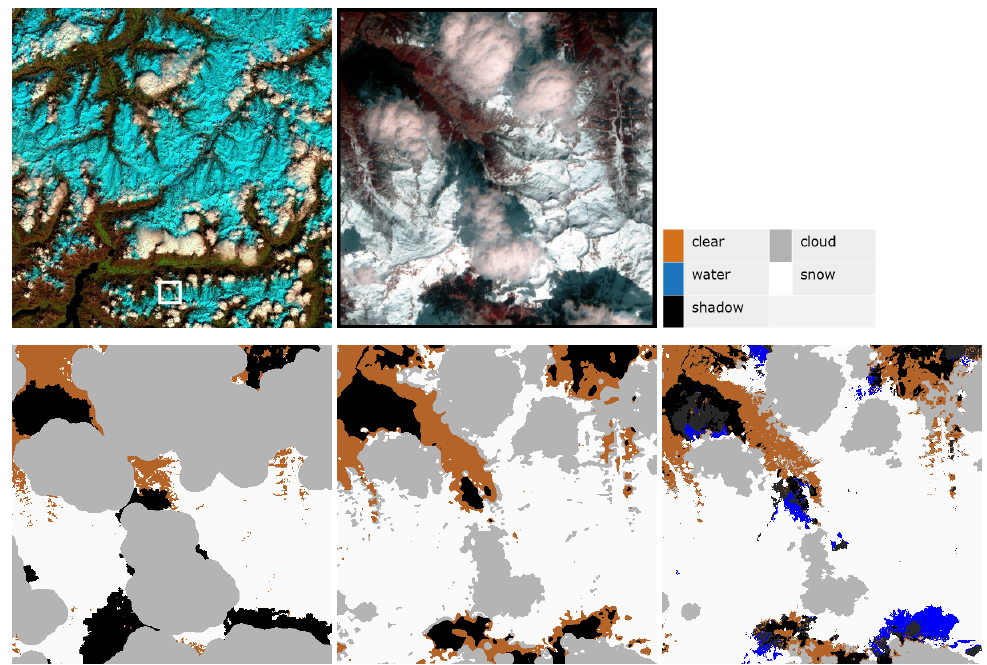
Figure 8. Top row (left to right): SWIR1/NIR/red composite and CIR (RGB = 865,665,560nm) subset of scene ID 19 (Davos). Bottom row (left to right): Fmask, ATCOR and Sen2Cor classification maps.